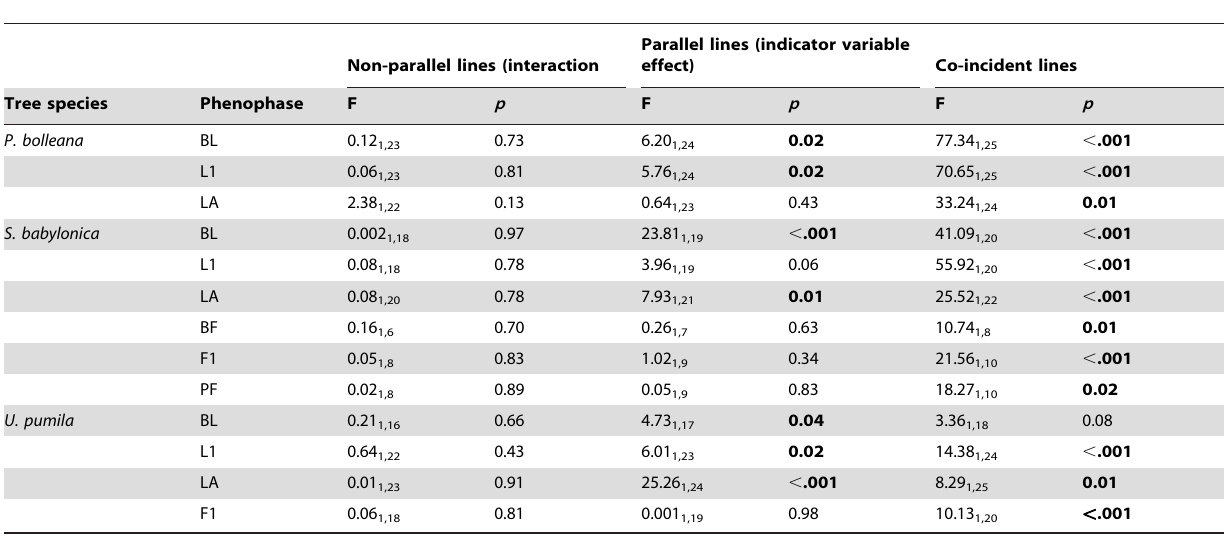
Table 2. Analysis of covariance (ANCOVA) testing differences between linear regression fits to historical and spatial phenological observations.